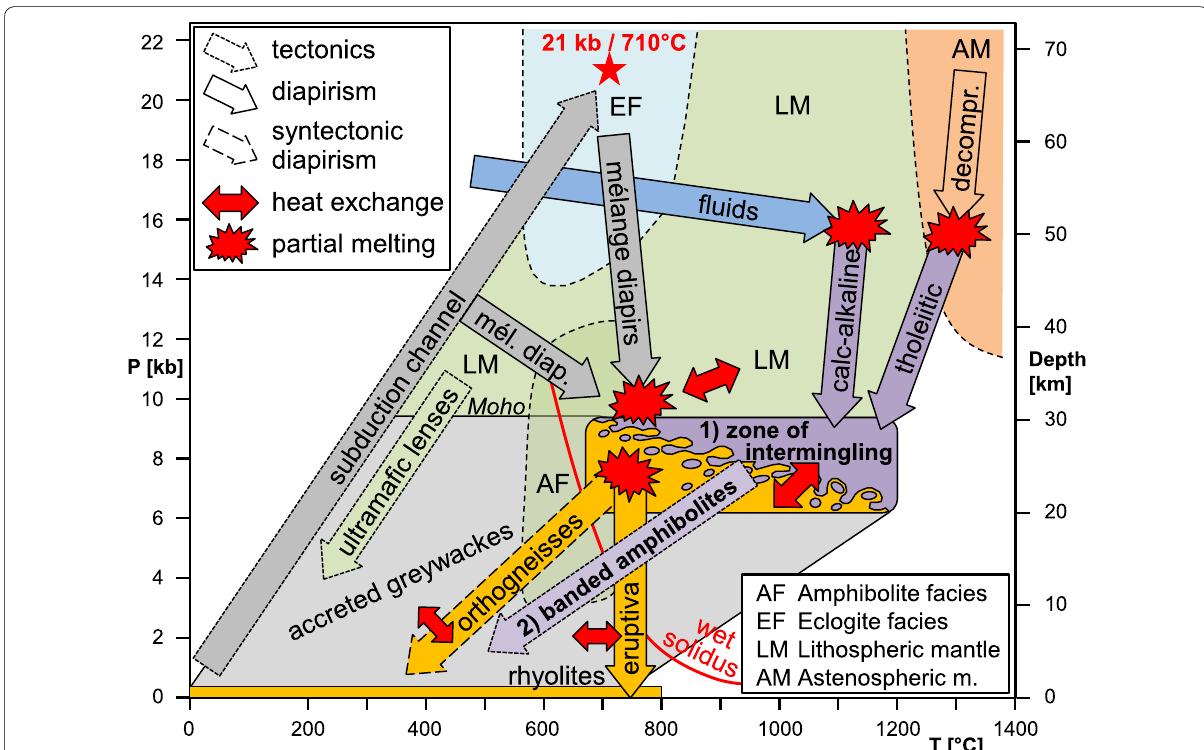
Fig. 14 P-T diagram illustrating production of banded amphibolite formations in two steps: Step 1: Magma interaction processes in the “zone of intermingling” (c. 5–10 km thick) at the base of the accretionary complex. Step 2: Steep thrusts cut the accretionary complex and intersect the “zone of intermingling”. The tectono-metamorphic and magmatic processes correspond to the illustrations in Fig.